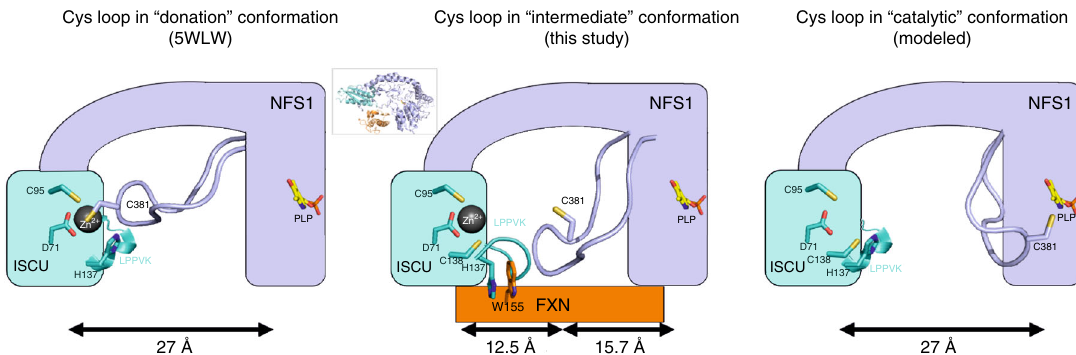
Fig. 4 Proposed mechanistic features of FXN activation on NFS1 and ISCU. Schematic of the NFS1 Cys-loop trajectory, mediated by FXN-induced conformational changes on ISCU in the LPPVK region. Subunits of NFS1, ISCU and FXN are colored violet, cyan and orange respectively. Key residues discussed in the text are shown as sticks. The Cys-loop from NFS1 is shown as coil, and the LPPVK region Inset shows the orientation of complex from which the cartoon representation is